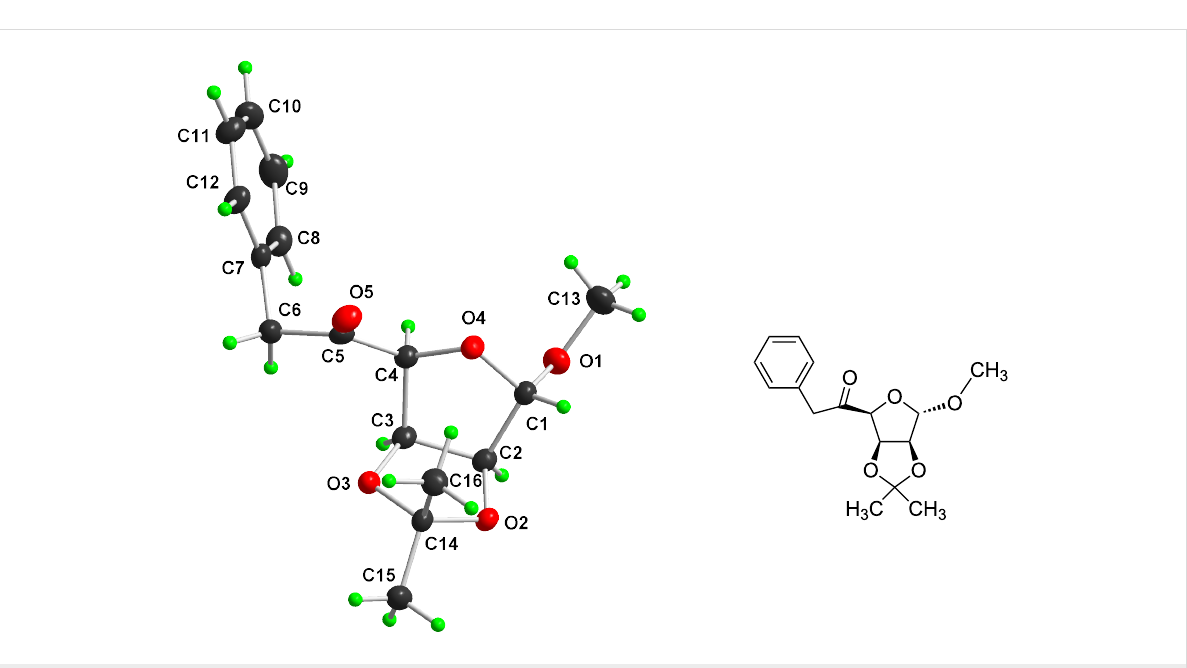
Figure 2: Molecular structure (DIAMOND drawing with adjacent ChemDraw image) of benzyl derivative 9 . Atomic displacement ellipsoids are drawn at 50% probability level and H atoms are shown as small spheres of arbitrary radii.